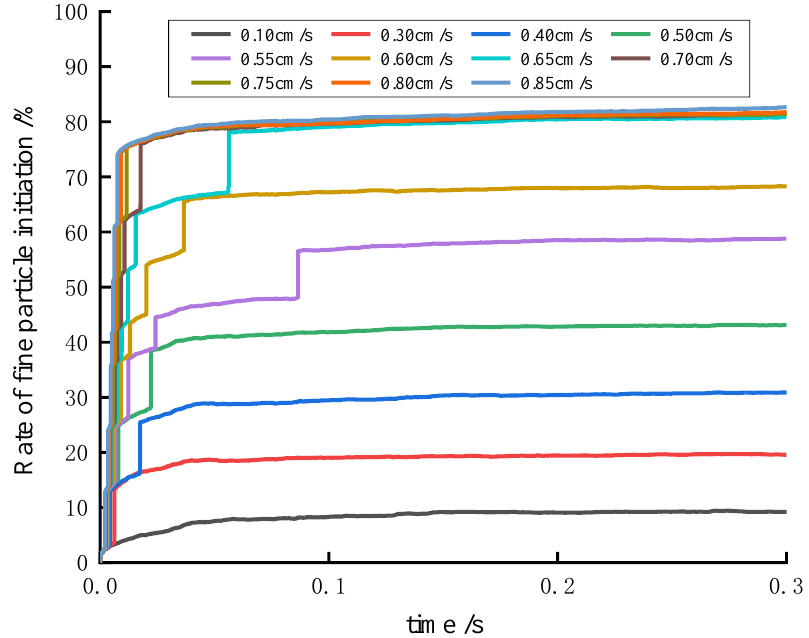
Figure 5. Variation in the rate of fine particle initiation. Table 2. The critical velocity, calculated by formula and numerical simulation under different conditions. Direction of Sample